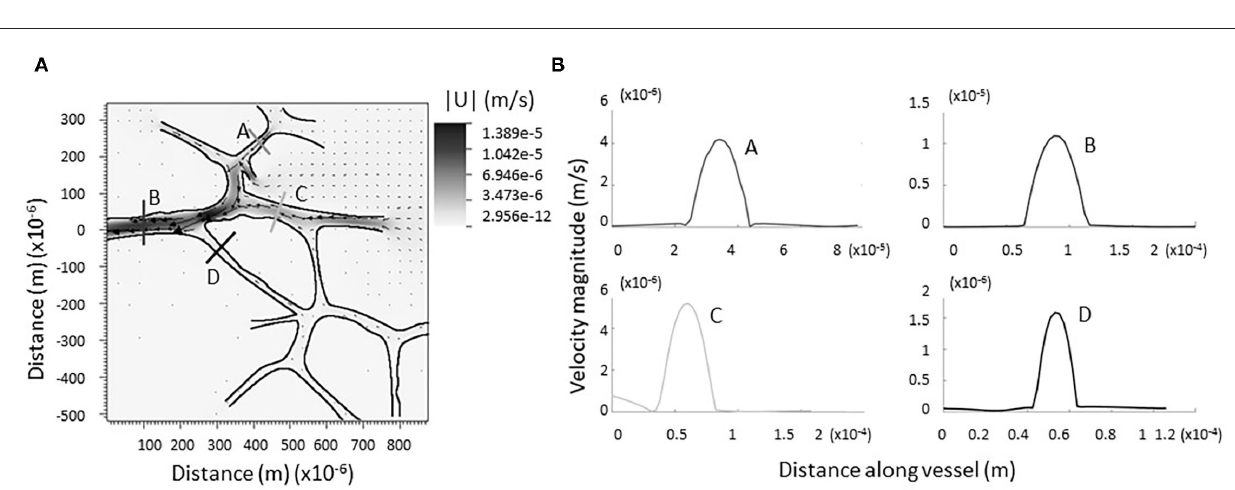
In addition to efficient lymph transport, it is necessary for the structure of the lymphatic capillaries to ensure well- mixed fluid in the daughter vessels. As the lymph is